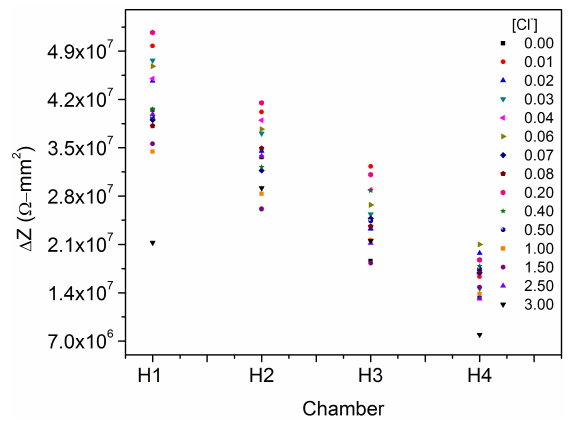
Figure 14. General behavior of ∆ Z in presence of chloride solutions according to the chamber where the measurement was taken, the frequency is 60,016 Hz. Concentration units in wt %.